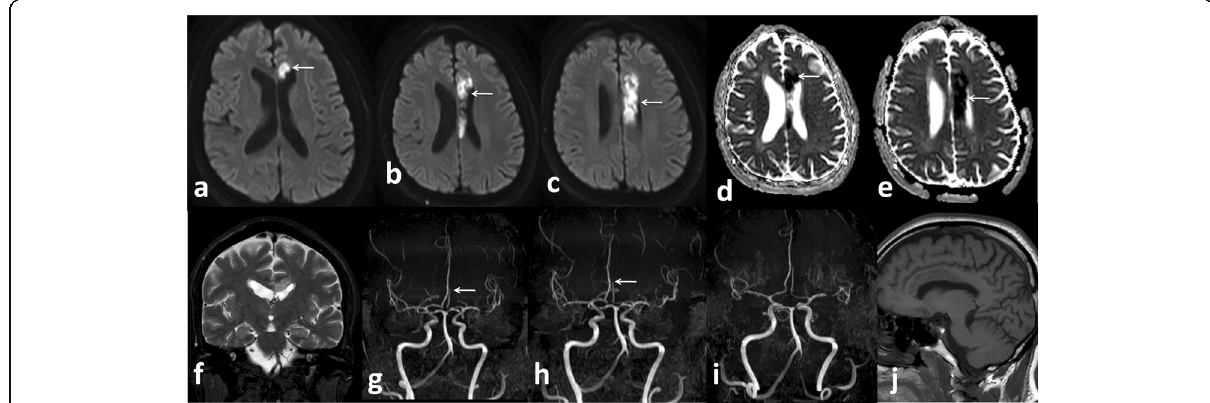
Fig. 8 Female patient 54 years old. Left ACA territory infarction. DWI (white arrows in a , b , c ), ADC map (white arrows in d and e ), MRA defective A3 segment of left ACA (white arrows in g and h